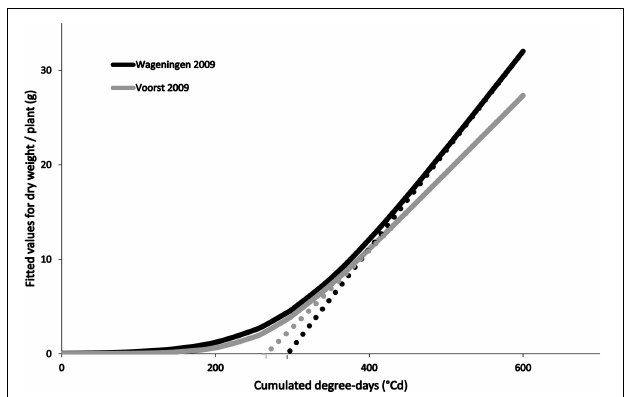
FIGURE 2 | Fitted values for dry weight accumulation over thermal time (based on average curve parameters for cultivars and transplant sizes within a trial, cf. Table 2) in Wageningen 2009 and Voorst 2009. The asymptotes to the expolinear curves cut the x-abscissa at the values obtained for “lag phase” which are, in this case, 293 ◦ C for Wageningen 2009 and 262 ◦ C for Voorst